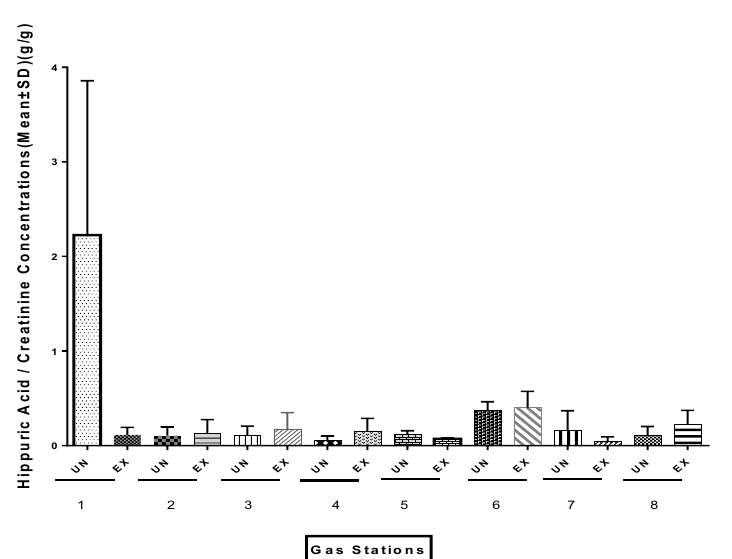
Figure 1. Mean concentrations of HA (g/g creatinine) at each gas station in the control and exposed groups regardless of the Figure 1. The Mean Concentrations of HA (g/g creatinine) at Each Gas Station in the Control and Exposed Groups season variable Regardless of the Season Variable (UN: control group; EX: exposure group) UN: Control group; EX: Exposure group.